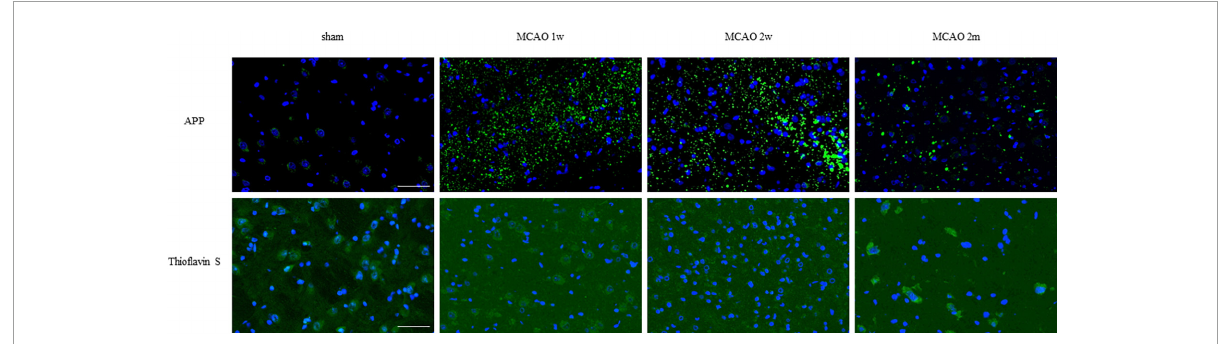
FIGURE6 APP and mature amyloid plaque in the ipsilateral thalamus VPN. There was little APP deposition in the ipsilateral thalamus of sham rats. At the 1st week, the 2nd week, and the 2nd month after MCAO, APP deposition (green) showed a trend from less to more and gradually decreased in the ipsilateral thalamus VPN. Using Thioflavin S staining, no abnormal mature amyloid plaque was found in the ipsilateral thalamus VPN at each group after MCAO. Bar = 50 µ m. APP, beta-amyloid precursor protein; VPN, ventroposterior nucleus; MCAO, middle cerebral artery